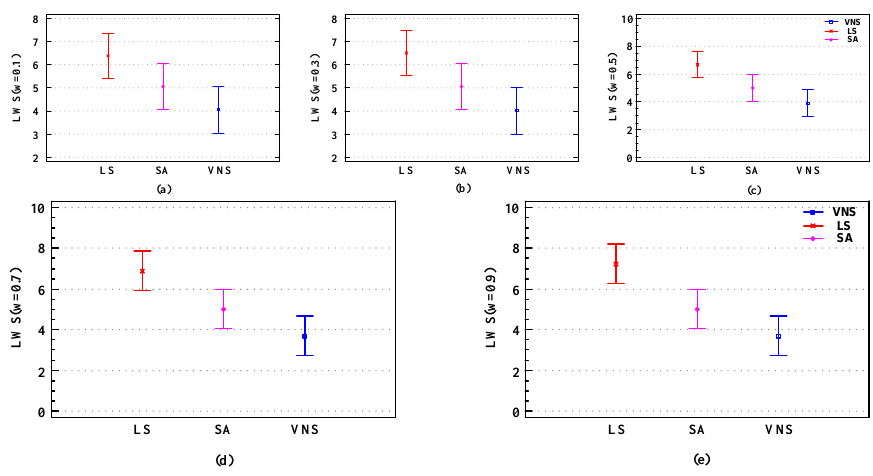
Figure 11. The result of linear weighted sum. ( a ) LWS (w = 0.1), ( b ) LWS (w = 0.3), ( c ) LWS (w = 0.5), ( d ) LWS (w = 0.7), ( e ) LWS (w = 0.9).